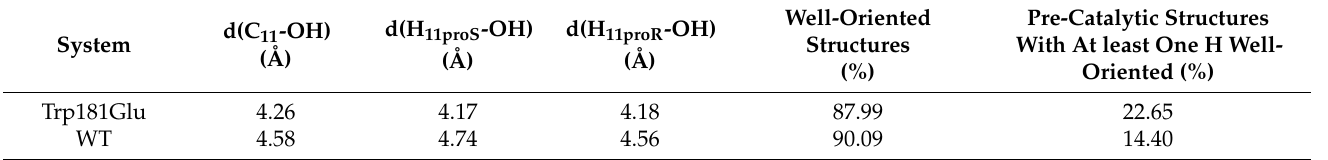
Table 3. Average distances of C 11 (d(C 11 -OH)) and its hydrogen atoms H 11proS (d(H 11proS -OH)) and H 11proR (d(H 11proR -OH)) of LA to the iron-bound OH-group for the Trp181Glu-ALOX15-LA and WT-ALOX15-LA complexes 1